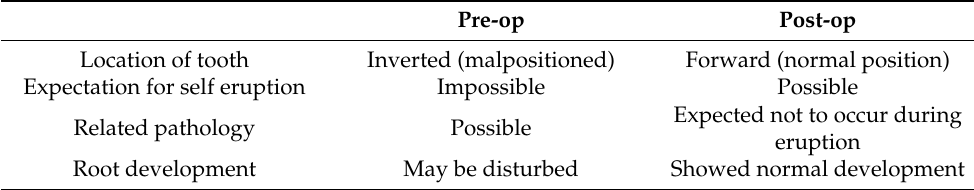
Figure 4. ( A ) Immediate postoperative panoramic view; ( B ) Postoperative 3 months panoramic view, arrow: repositioned central incisor, arrowhead: developing root. Table 1. Postoperative results compared to preoperative condition.